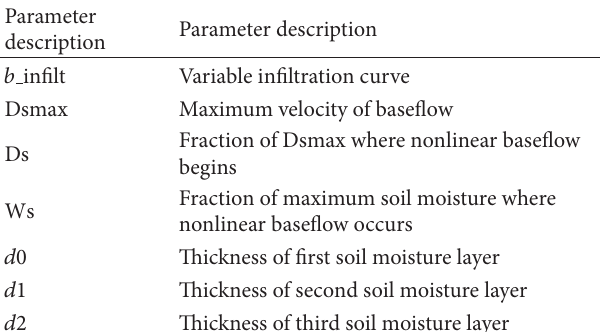
Table 1: Seven VIC user calibrated hydrological